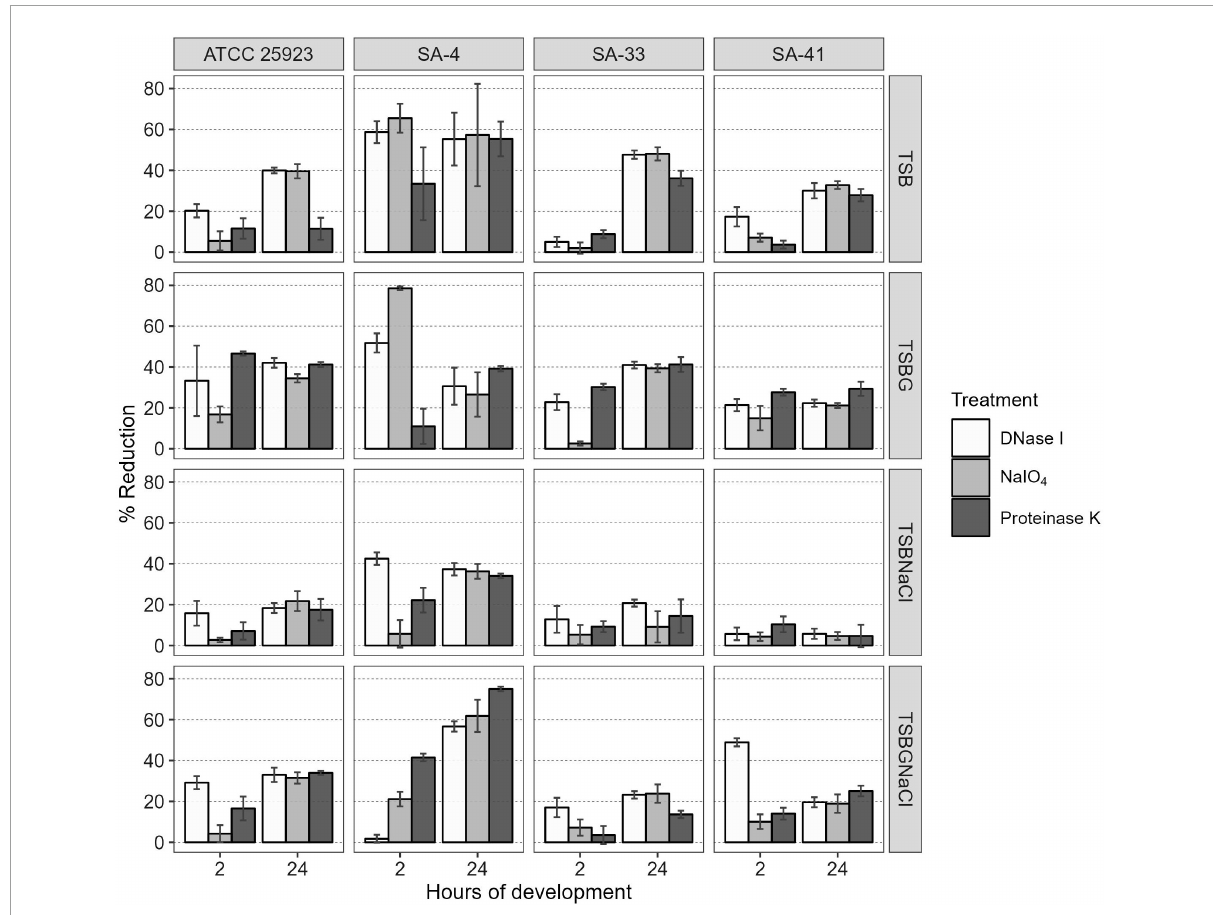
FIGURE3 Percentage reduction of S. aureus biofilms after treatment with DNase I, NaIO4, or proteinase K at 2 and 24 h of maturity. SA, S. aureus ; TSB, Tryptic soy broth; TSBG, TSB + 0.4% Glucose; TSBNaCl, TSB + 4% NaCl; TSBGNaCl, TSB + 0.4% Glucose + 4%